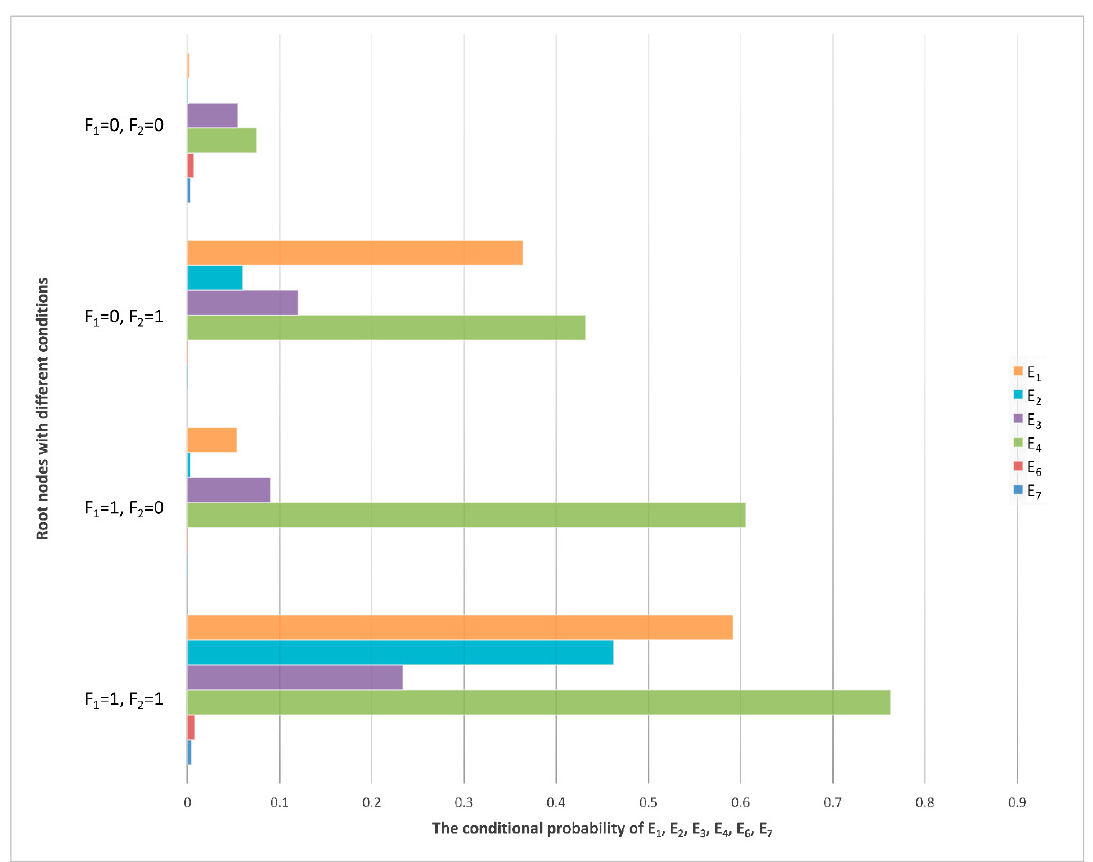
Figure 8. Conditional probability distribution diagram of the first layer sub-nodes.